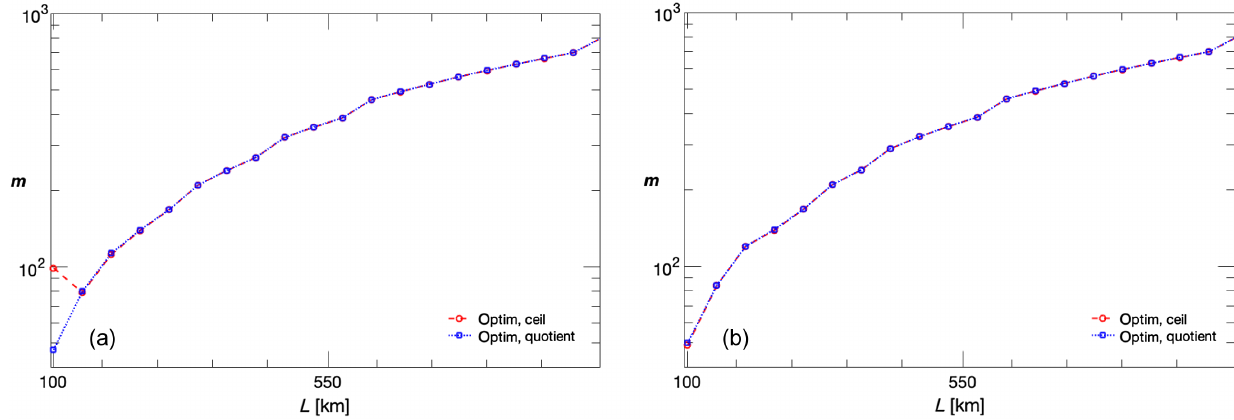
FIG. 2. Optimal number of repeater stations ( m ) corresponding to the new optimizations of the generic two-way repeater shown in Fig. 1. Panels (a) and (b) correspond to Figs. 1(a) and E1(b). In the figure legends, “ optim, ceil ” ( “ optim, quotient ” ) refers to an optimization using the ceiling (quotient) function. We note that the optimal number of repeater stations is very similar for both optimizations, resulting in almost overlapping curves. For the ceiling function, the number of spin qubits per repeater station is found to be 4 for all distances in panels (a) and (b) except d ¼ 100 in (a). For the quotient function, the optimal number of spin qubits per repeater station is 2 for all distances in both (a) and